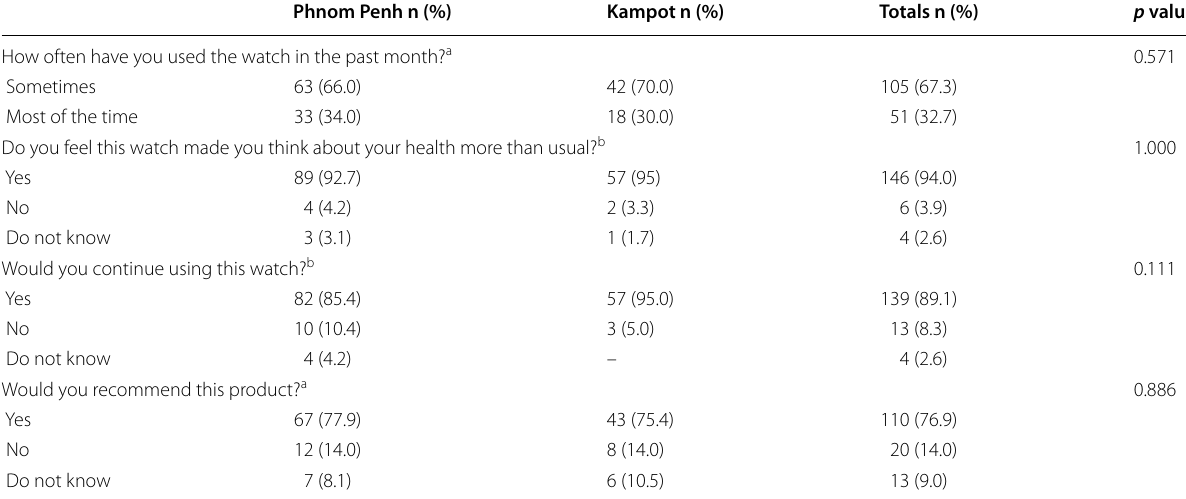
a Chi square b Fisher’s exact test